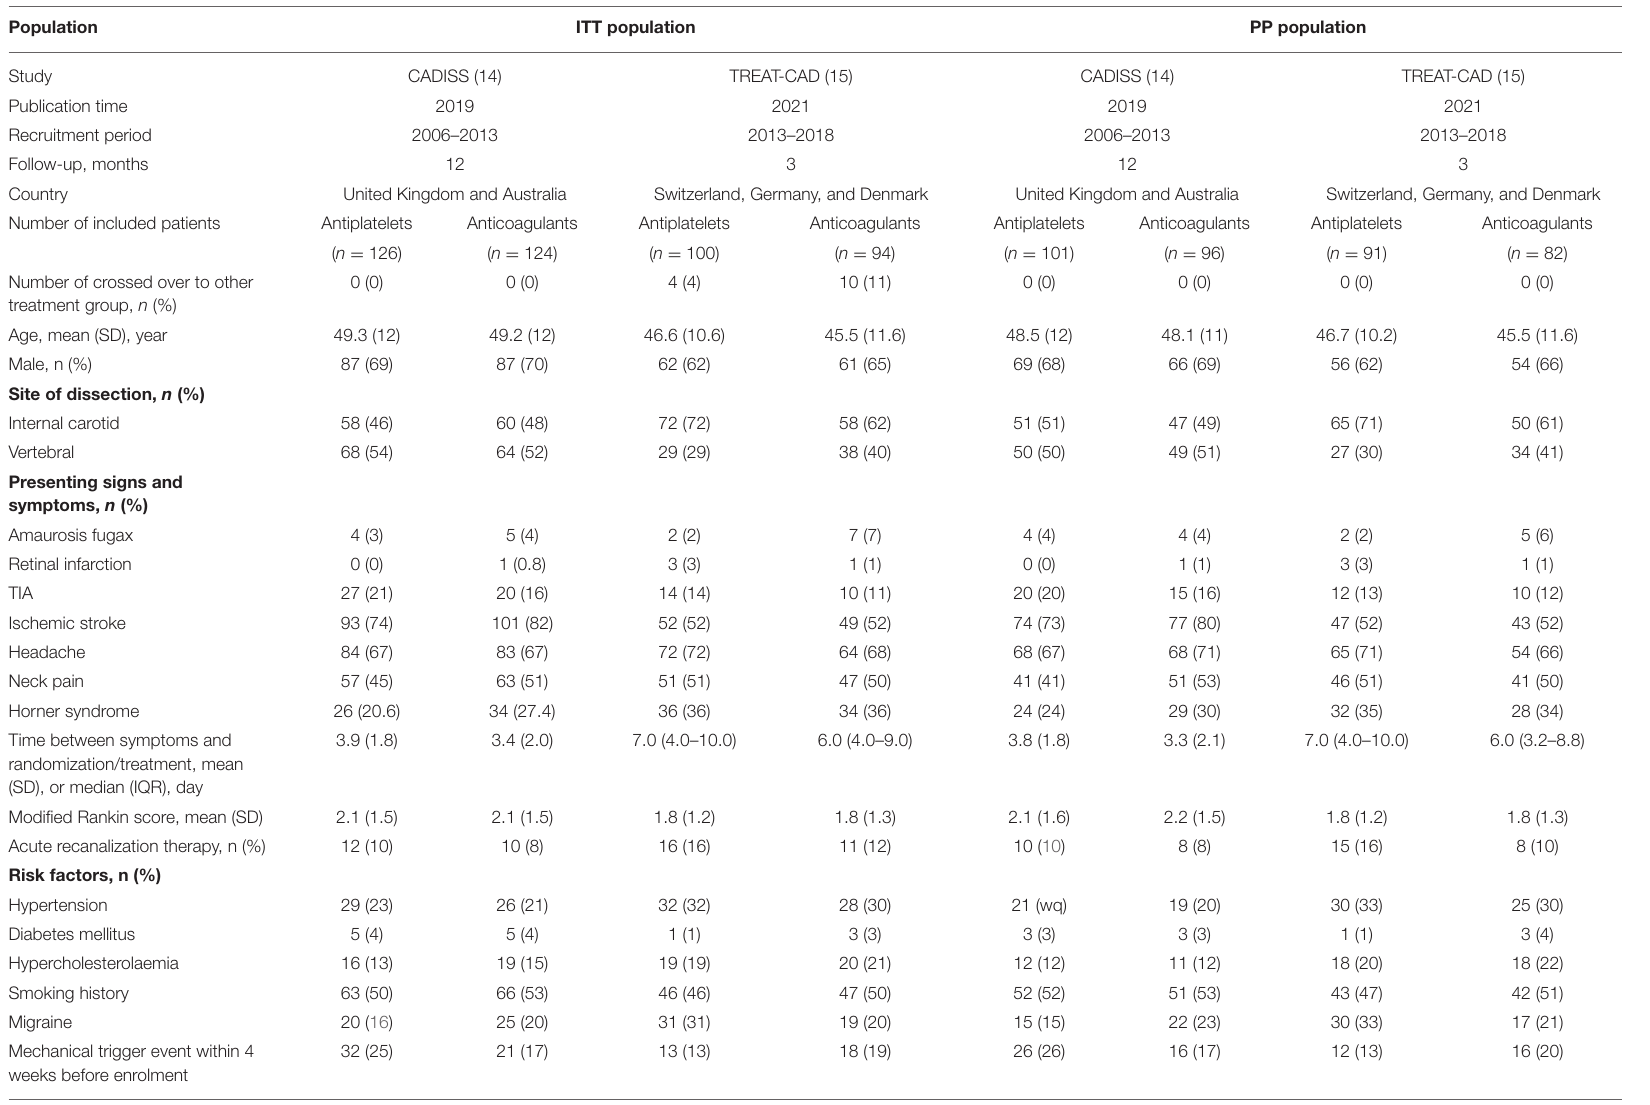
TABLE 1 | The characteristics of the included studies and